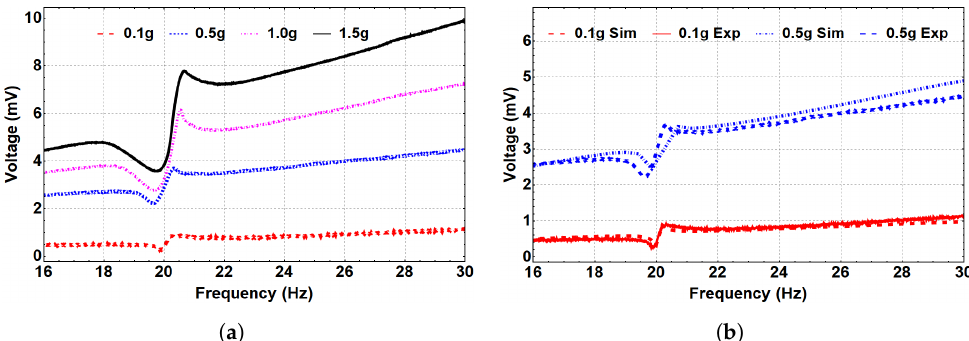
Figure 7. The frequency–voltage curve for different excitation levels at the monostable regime ( d = 35 mm). ( a ) Experimental results. ( b ) Simulated results with experimental